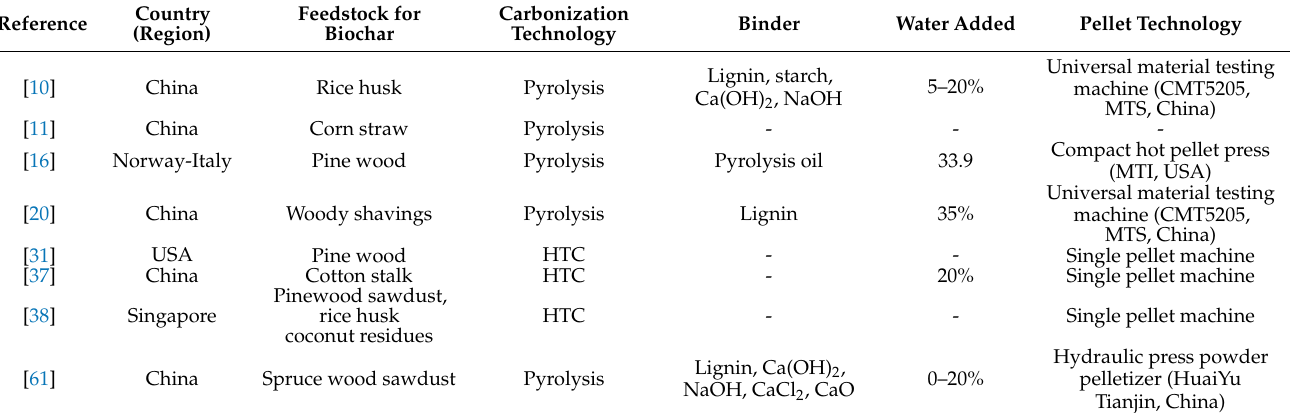
Table 1. List of published papers presenting recent methods for pelletizing biochar produced from different biomass